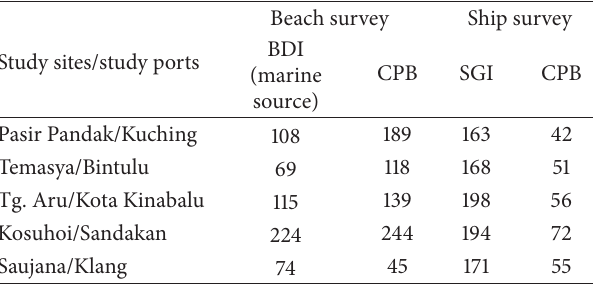
Table 5: Mean BDI (marine source) (item/km), SGI (item/vessel), and CPB found during beach and ship